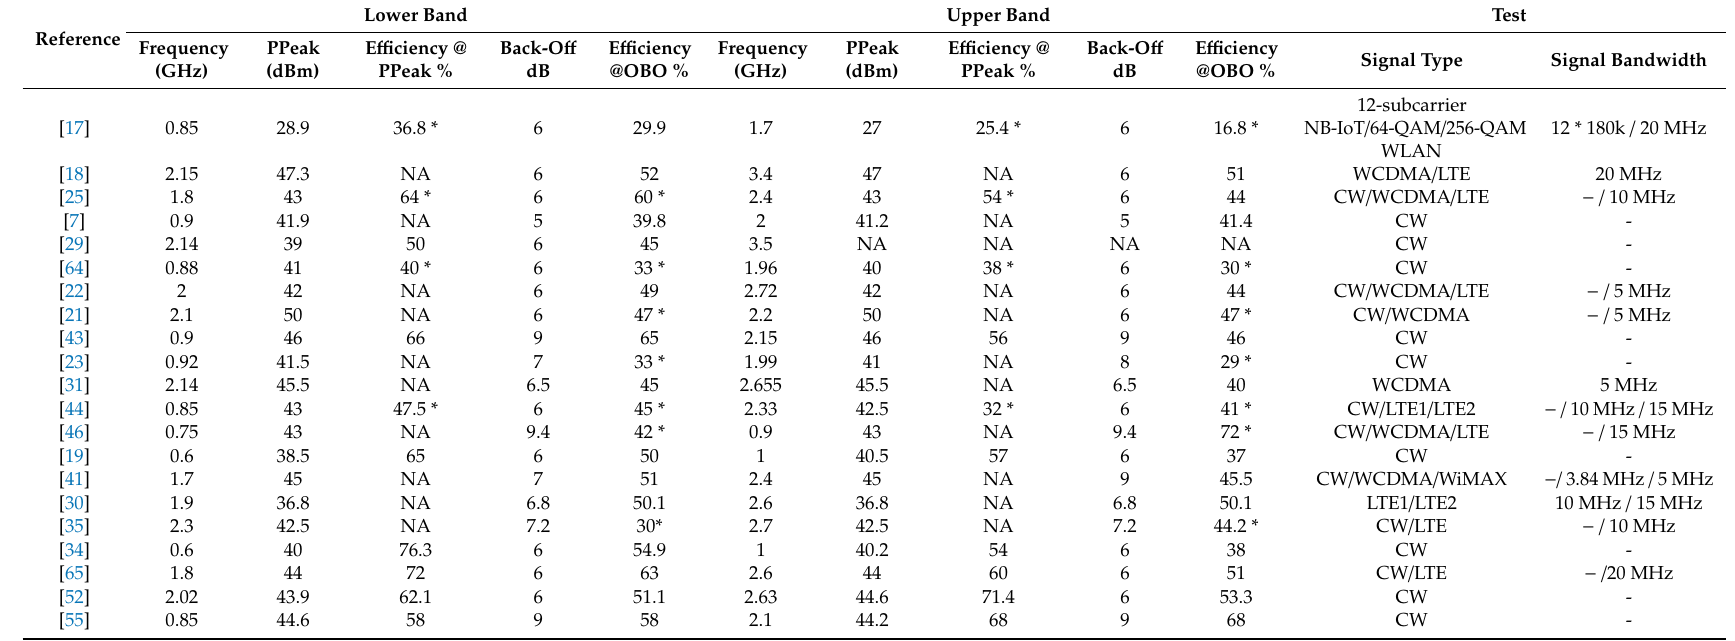
Table 2. Samples of achieved dual-band